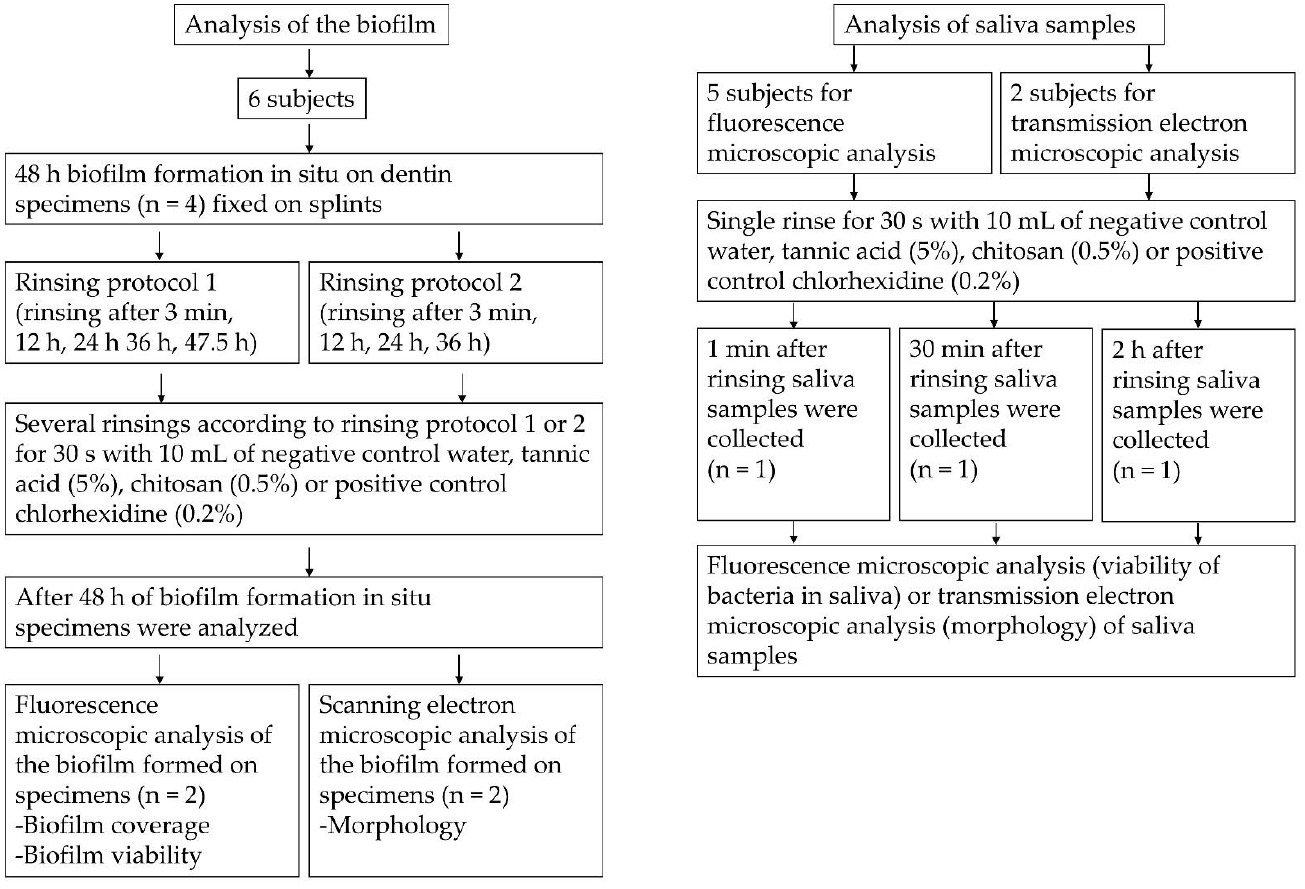
Figure 6. Flow chart of the in situ experiments. Table 1. Modified scoring for biofilm coverage according to Xi et al. [25].